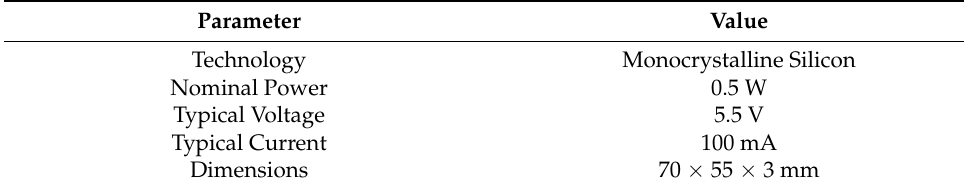
Figure 1. Architecture of the developed Wireless Monitoring System. Table 2. PV panel main parameters.